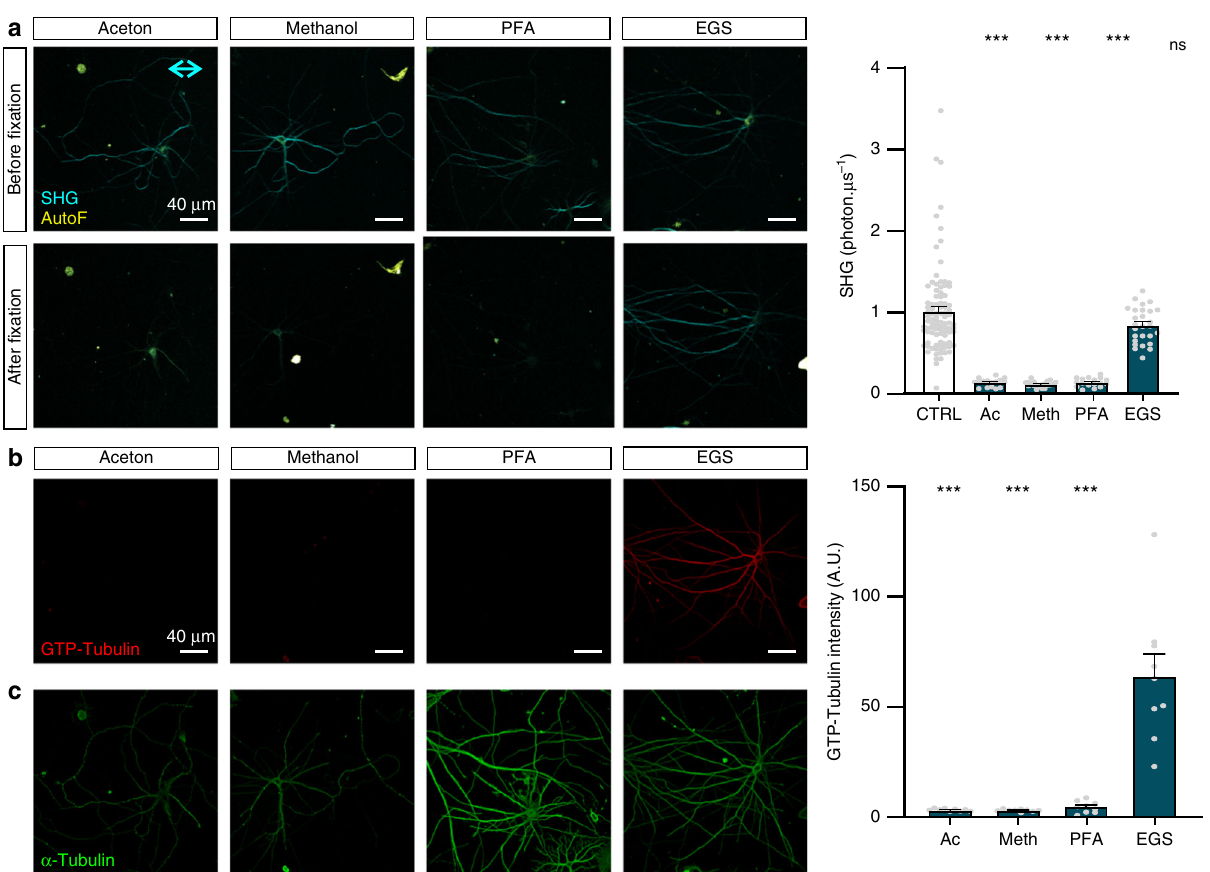
Fig. 4 Fixation alters SH signals and tubulin conformations. a Recordings of SH signals before and after fi xation with acetone (Ac, n = 16 cells from three independent experiments), methanol (Meth, n = 20 cells from three independent experiments) and paraformaldehyde (PFA, n = 19 cells from three independent experiments), which all lead to a loss of the SH signal while ethylene glycol bis succinimidyl succinate (EGS, n = 27 cells from three independent experiments) fi xation preserves the SH signal intensity compared to the controls before fi xation (CTRL; n = 94 cells from six independent experiments; *** p < 0.001 one-way ANOVA Dunn ’ s multiple comparison test). b MB11 staining and quanti fi cation for GTP-bound tubulin dimers after